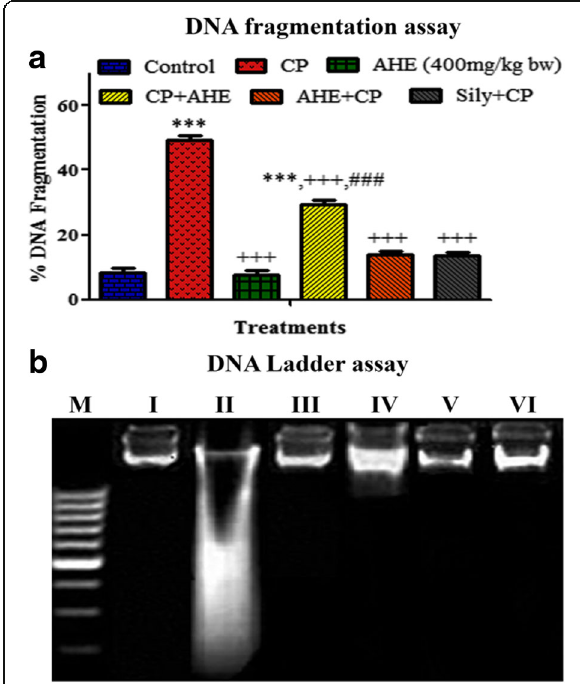
Fig. 1 a DNA fragmentation (%) in different treatment groups, ( b ) Agarose gel showing DNA damage by CP and protective effects of Pre and post treatment of AHE and silymarin in pulmonary tissue. Lanes from left (M) low molecular weight marker, (I) control, (II) CP group, (III) AHE (400 mg/kg bw) group, (IV) CP + AHE group, (V) AHE + CP group, (VI) Sily + CP